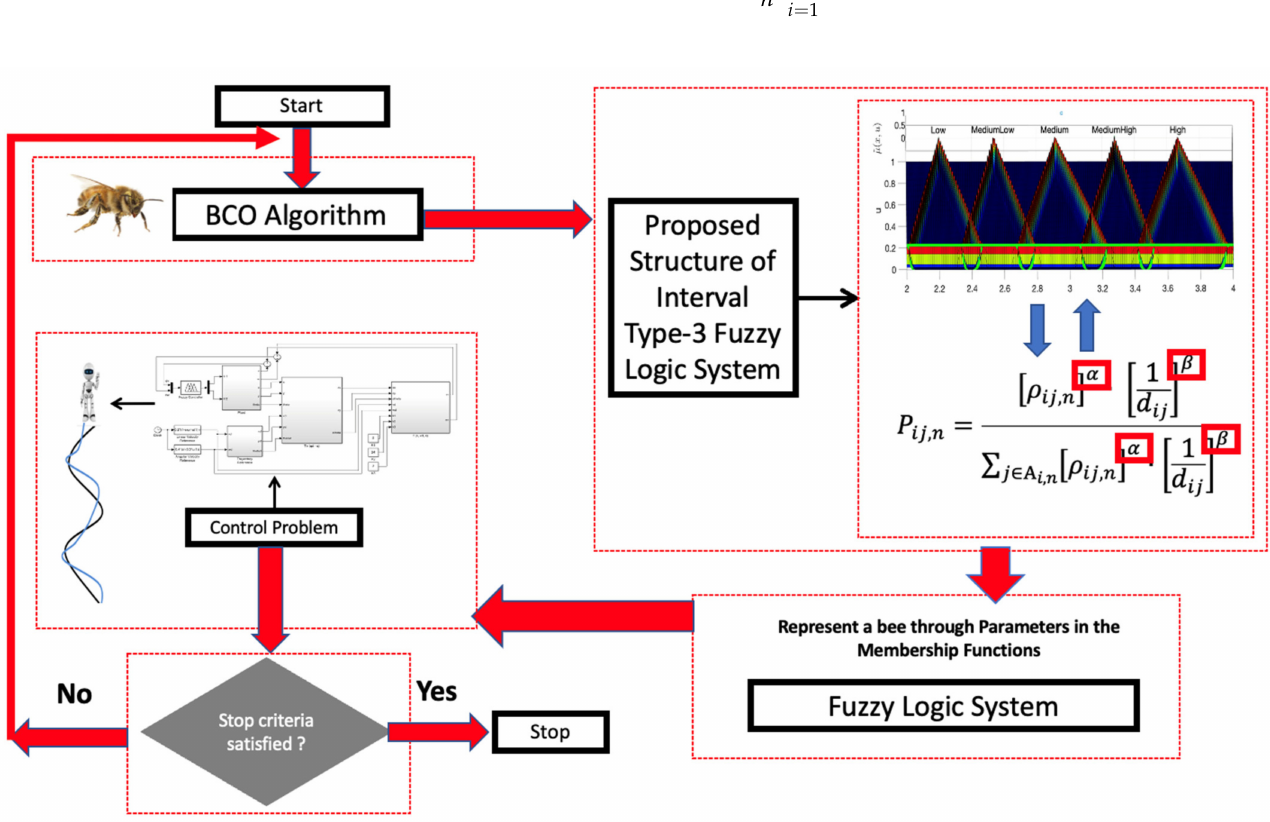
Figure 19. Graphical representation for the Fuzzy BCO